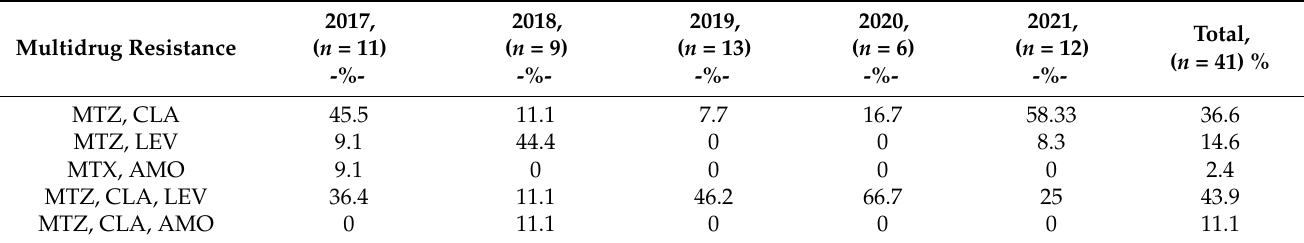
Table 2. Multidrug resistance of the secondary H. pylori isolates from 2017–2021 ( n = 41).